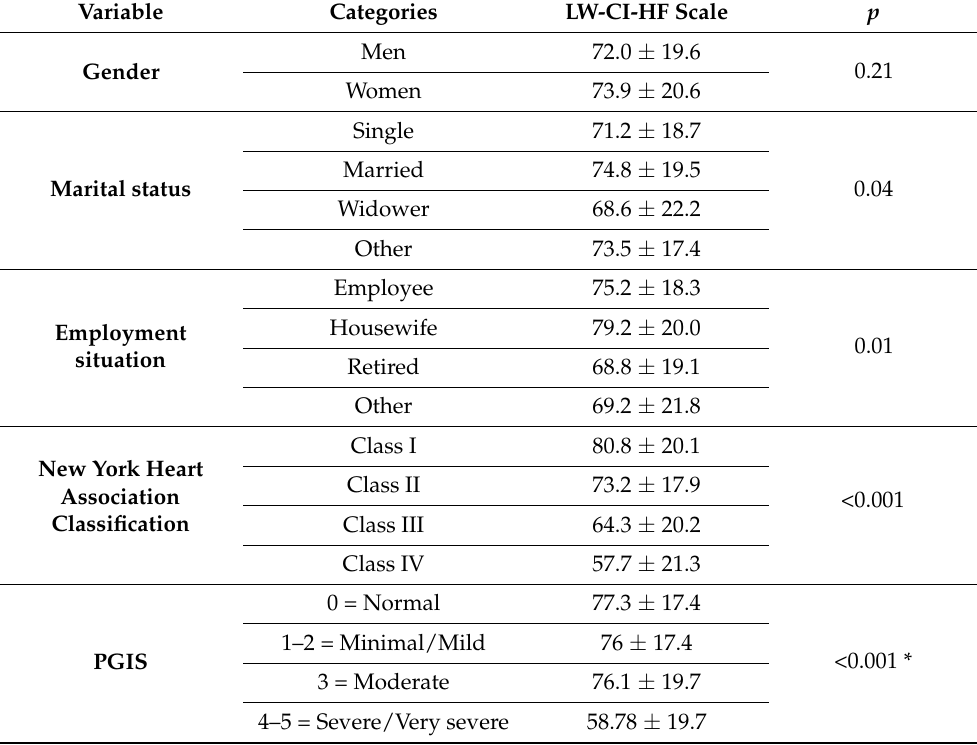
Table 4. Known-groups